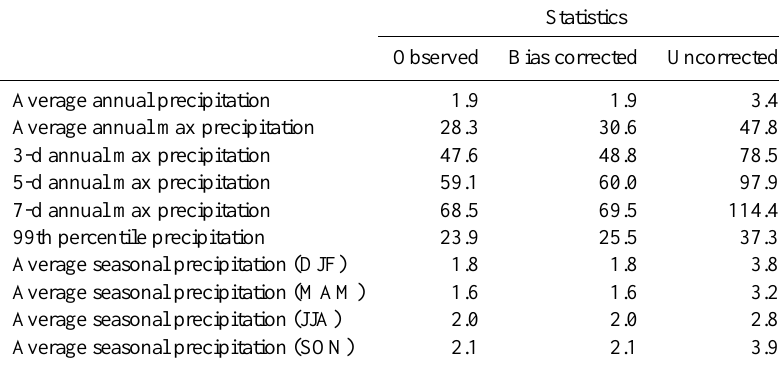
Fig. 2. Ratio between HIRHAM5-ECHAM5 simulations and observations of seasonal average precipitation for the control period 1961– 1990. First row, uncorrected seasonal precipitation; second row, bias corrected seasonal precipitation. Table 1. Summary statistics of precipitation (mmd − 1 ) for the control period